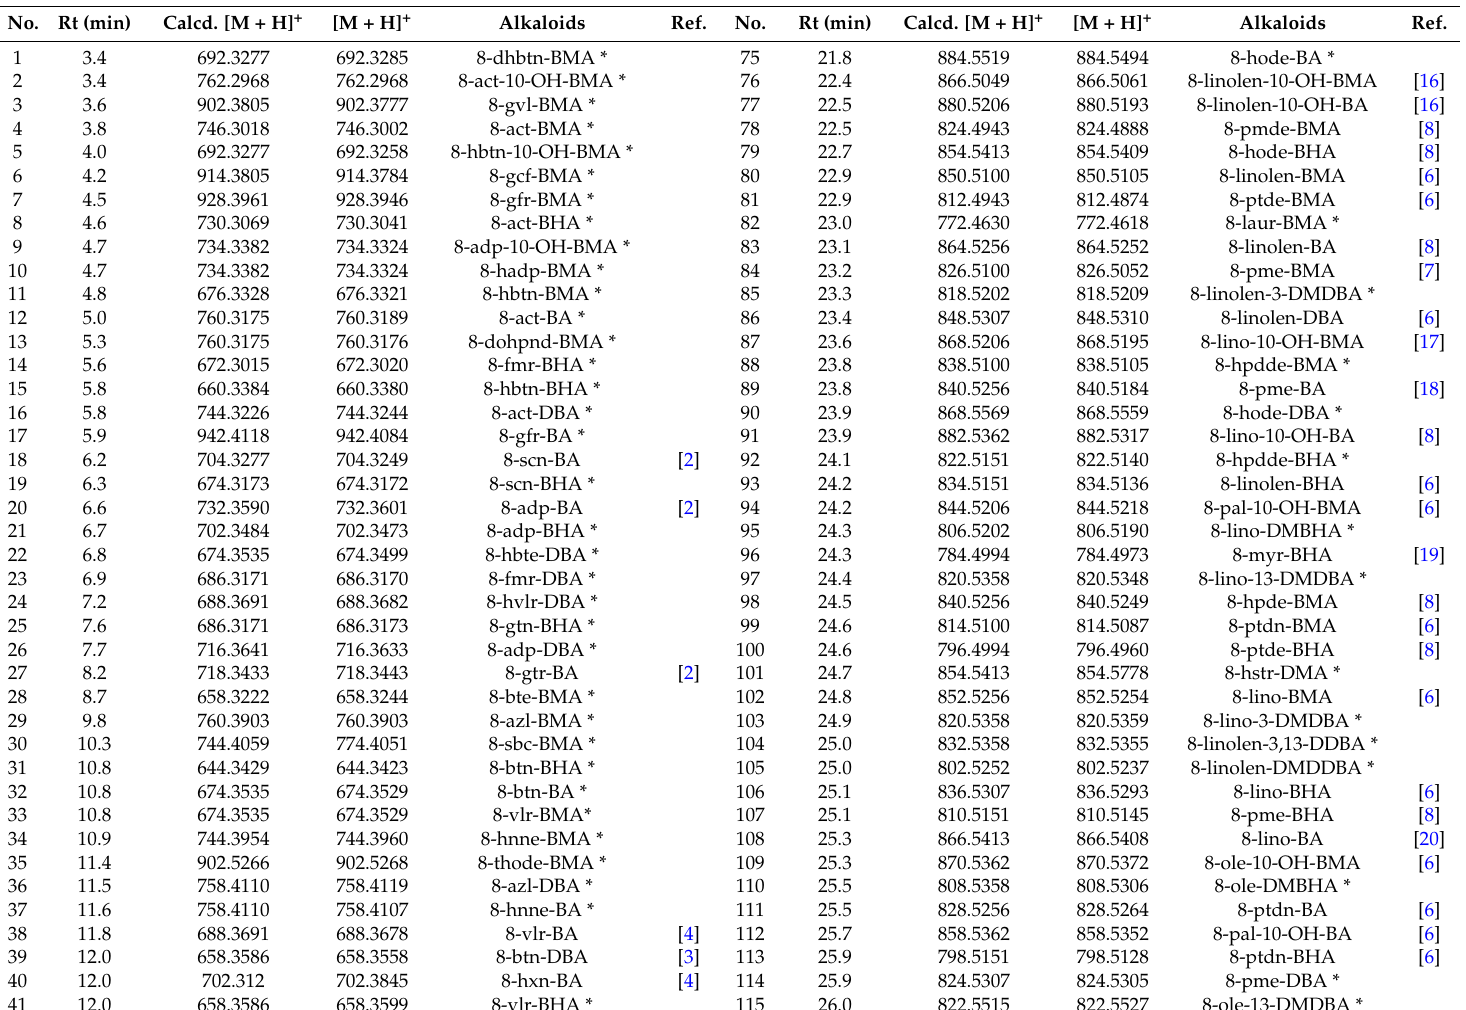
Table 2. Lipo-alkaloids identified from A. carmichaelii